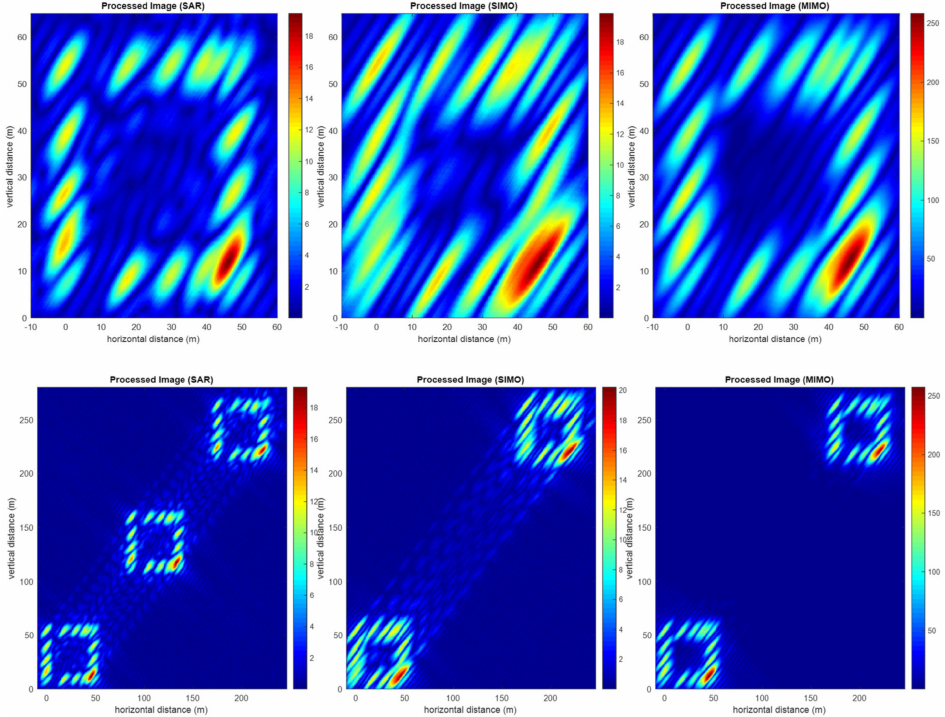
Figure 28. The simulated 2D images for Example 6 for SAR/SIMO/MIMO modes. Upper row: fine scene resolution (20 cm), small scene extent. Lower row: coarse scene resolution (1 m), large scene